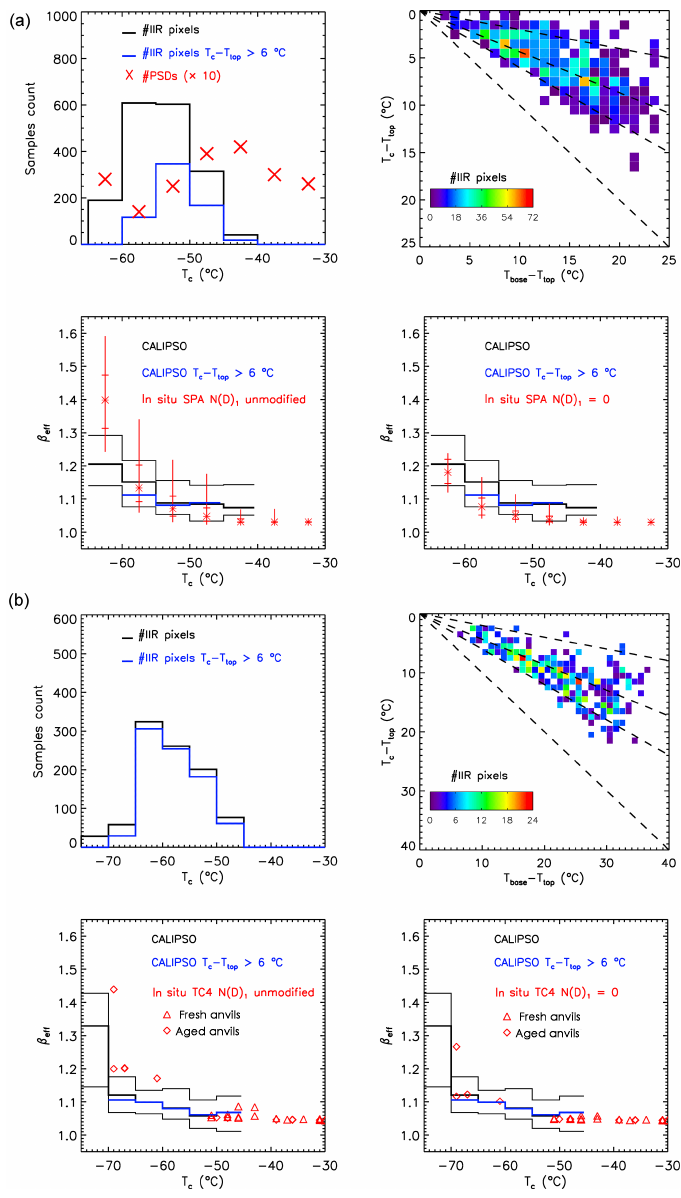
Figure 6. (a) Statistical comparison of CALIPSO IIR β eff and in situ β eff (synoptic cirrus) during SPARTICUS (sampled January– April 2010). Top left: the red X symbols indicate the number of PSDs used in the SPARTICUS analysis (multiplied by 10 for clarity of presentation) within 5 ◦ C in situ temperature intervals, while the black histogram indicates the number of CALIPSO IIR pixels in each T c temperature interval, and the blue histogram indicates the number of IIR pixels where T c − T top is larger than 6 ◦ C. Top right: 2D-histograms of T c − T top and T base − T top for the IIR pixels. The dashed lines from top to bottom are 20%, 43% (average value) and 60% from cloud top, with T c = T base for the lowest curve. Bottom: temperature dependence of in situ β eff derived assuming N(D) 1 unmodified (left) and N(D) 1 = 0 (right). The vertical lines give the measurement range, the horizontal bars give the 25th and 75th percentile values, and the asterisks give the median value. CALIPSO IIR median β eff is given by the thick black histogram, with thin black histograms giving the 25th and 75th percentile values. The thick blue histogram is CALIPSO IIR median β eff where T c − T top > 6 ◦ C. (b) Statistical comparison of CALIPSO IIR β eff and in situ β eff during TC4. Top left: the black histogram indicates the number of CALIPSO IIR pixels in each T c temperature interval, and the blue histogram indicates the number of IIR pixels where T c − T top is larger than 6 ◦ C. Top right: 2D-histograms of T c − T top and T base − T top for the IIR pixels. The dashed lines from top to bottom are 20%, 43% and 60% from cloud top, with T c = T base for the lowest curve, for comparison with SPARTICUS data. Bottom: temperature dependence of in situ β eff derived assuming N(D) 1 un- modified (left) and N(D) 1 = 0 (right) for fresh (red triangles) and aged (red diamonds) anvils. CALIPSO IIR median β eff is given by the thick black histogram, with thin black histograms giving the 25th and 75th percentile values. The thick blue histogram is CALIPSO IIR median β eff where T c − T top > 6 ◦